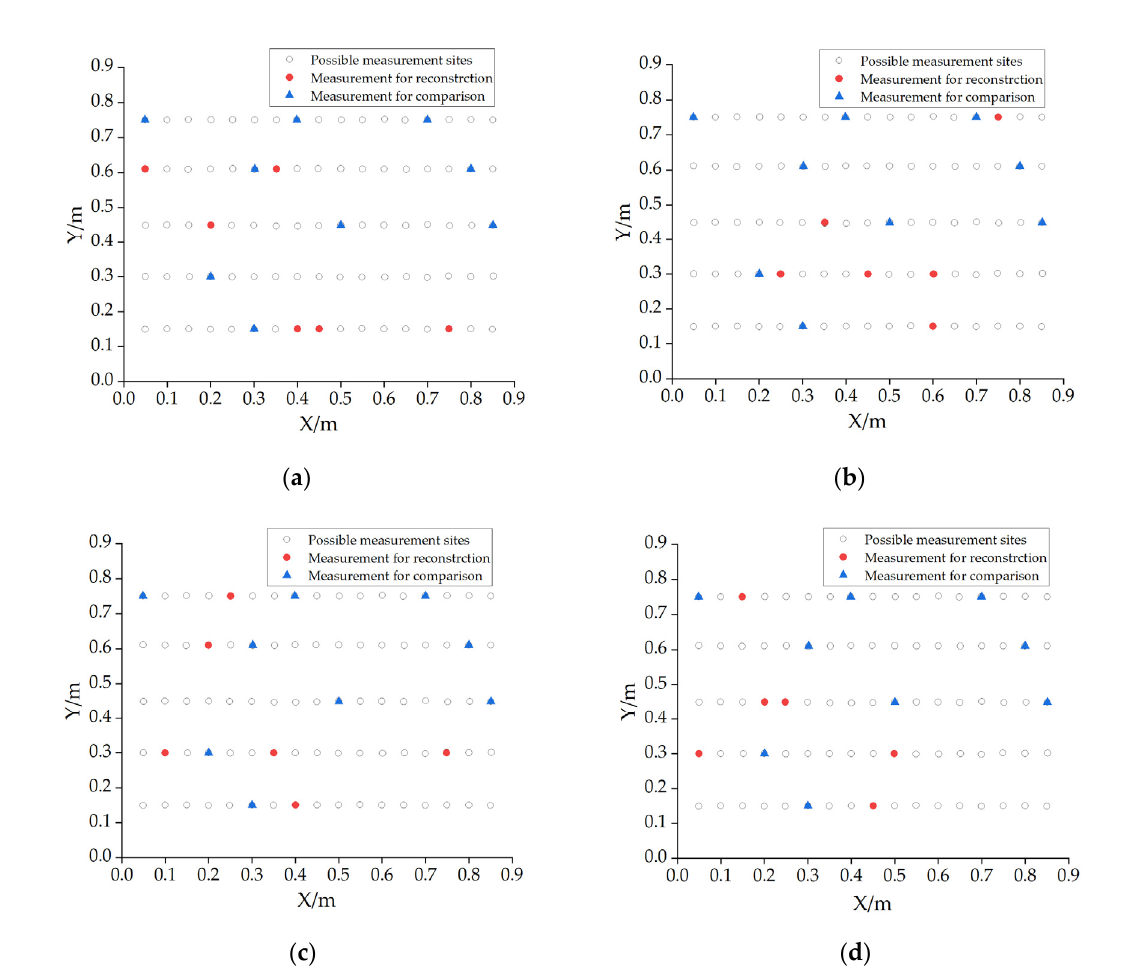
Figure 10. Sensor placements. ( a ) Optimal placement, ( b ) random placement 1, ( c ) random placement 2, and ( d ) random placement 3. 2, and ( d ) random placement